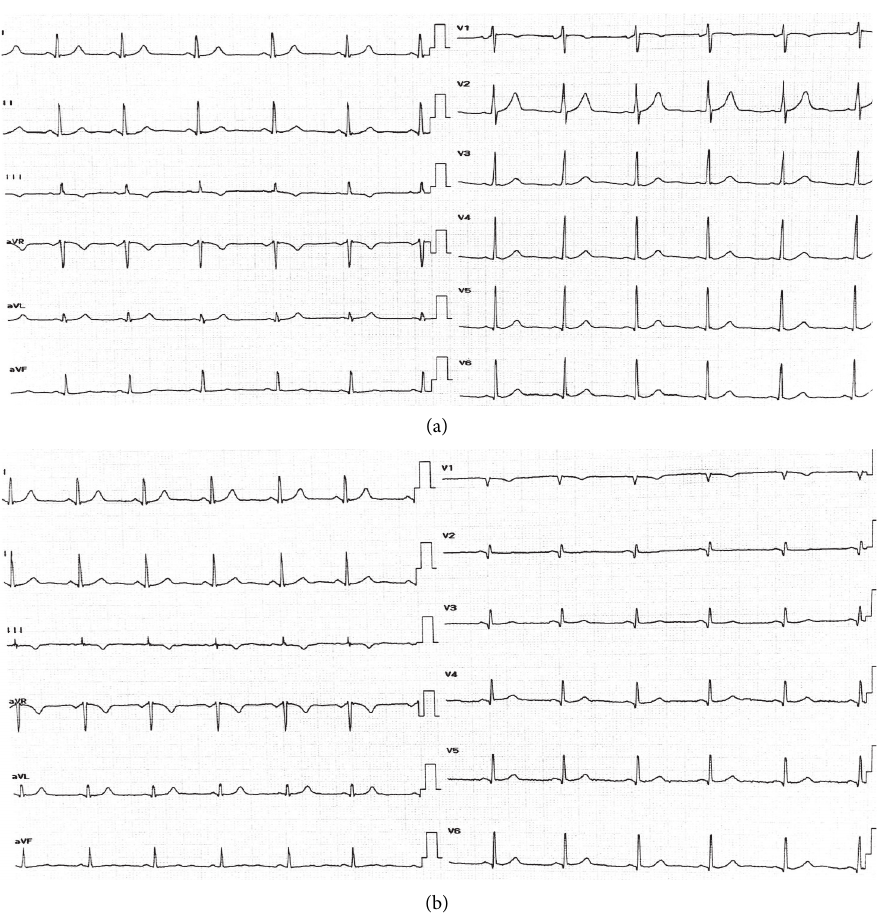
Figure 2: (a) Supine ECG, normal sinus rhythm, and normal frontal QRS axis. (b) Prone ECG in the same patient. Low QRS amplitude was noted in precordial leads, and new Q waves were seen in leads V1 to V3. Table 2: Effect of prone position on heart rate, mean electrical axis, QRS amplitude, QRS duration, PR, and QTc interval. Variable Supine Prone P value ∗ Heart rate